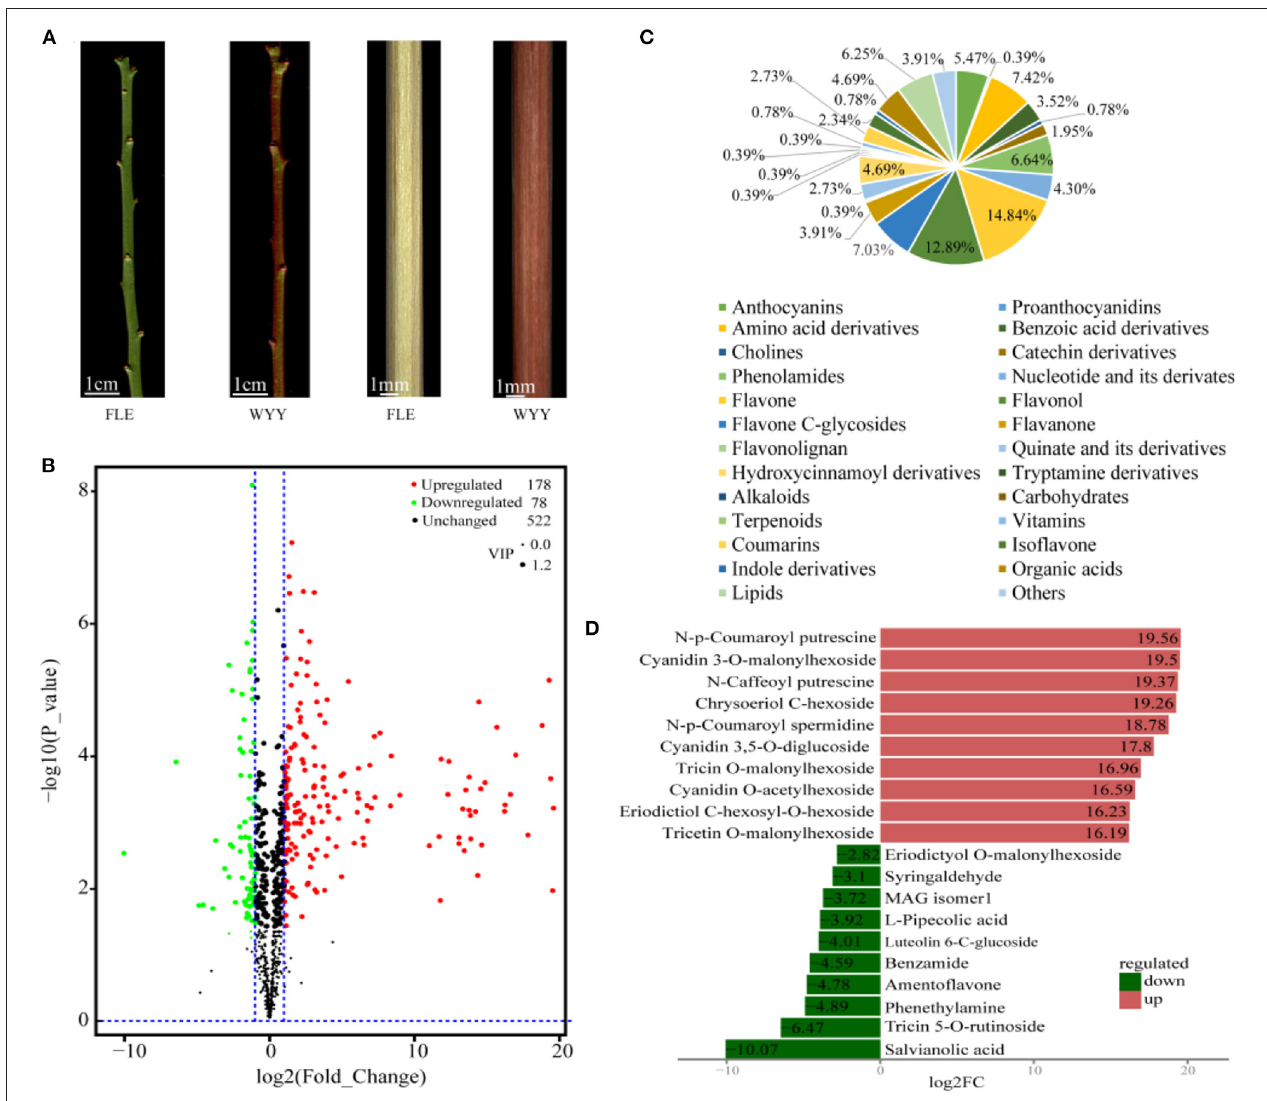
FIGURE 1 | Morphological characterization and differentially accumulating metabolites between WYY and FLE. (A) Green-stem cultivar ‘Fei Lve’ (FLE) and red-stem cultivar ‘Wuyuyu’ (WYY). (B) Volcano plot of the 778 metabolites identified. Differential metabolites were defined with fold change ≥ 2 or ≤ 0. 5, and VIP ≥ 1. (C) Pie chart depicting the biochemical categories of the differential metabolites identified between WYY and FLE. (D) The top 10 significantly differentially expressed